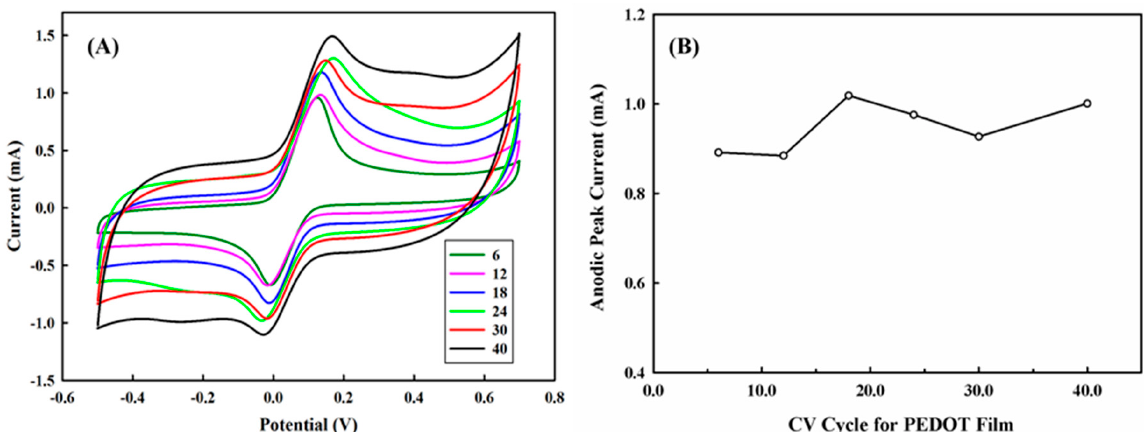
Figure 6. ( A ) The effect of cyclic voltammetry synthesis cycles, 6–40 cycles, on the performance of PEDOT/PL electrode for the detection of 6 mM of hydroquinone in 100 mM of PBS buffer. The potential was swept from − 0.5–0.7 V with the rate of 100 mV s − 1 . ( B ) The effect of CV cycles on the anodic peak current.